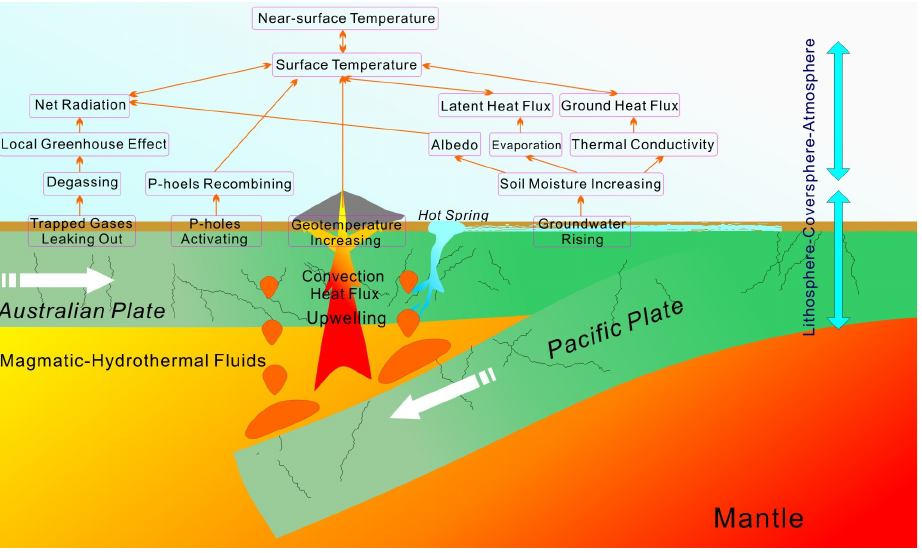
Fig. 9. A schematic plot of the LCAC mode interpreting the quasi-synchronous multi-parameter anomalies associated with the 2010– 2011 New Zealand earthquake sequence. Firstly, the magmatic-hydrothermal fluids, which upwelled via convection from the deep crust and mantle, had increased the geotemperature in particular zones, which were connected with subsurface fluids. Secondly, soil moisture increased due to the rising ground water level that had altered the physical properties of the land surface (i.e. thermal conductivity, albedo and evaporation), which led to local differences in latent heat flux and ground heat flux. Thirdly, the leaking out of trapped pore gases from underground to lower atmosphere had produced a local greenhouse effect, which resulted in more net radiation locally. Finally, positive holes were activated by stresses and recombined at the surface, which led to a stimulated electromagnetic emission in the TIR window and the heating of a thin surface